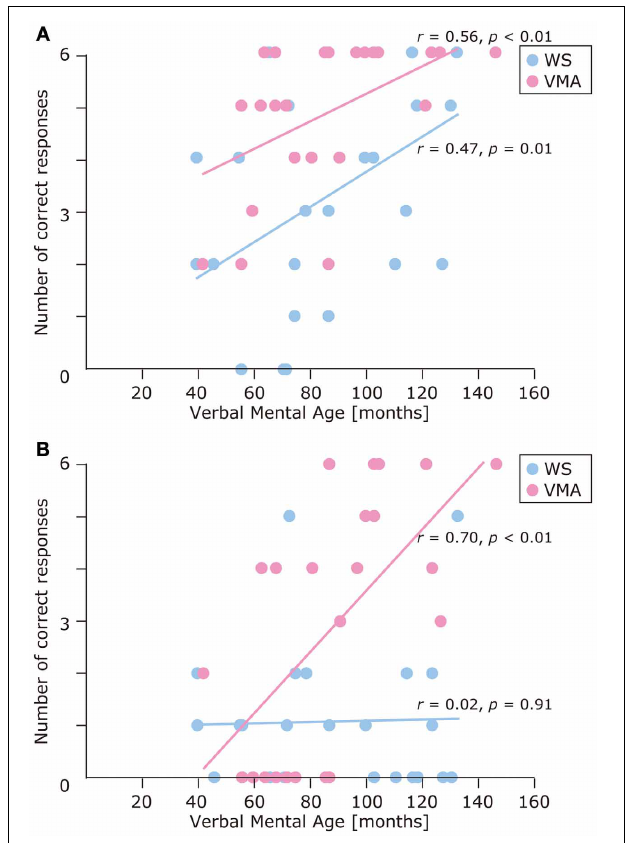
FIGURE 4 | Developmental trajectories for the number of correct responses in (A) the MR task, and (B) the VPT2 task, for two groups [blue: Williams syndrome (WS) group; pink: verbal mental age-matched (VMA)